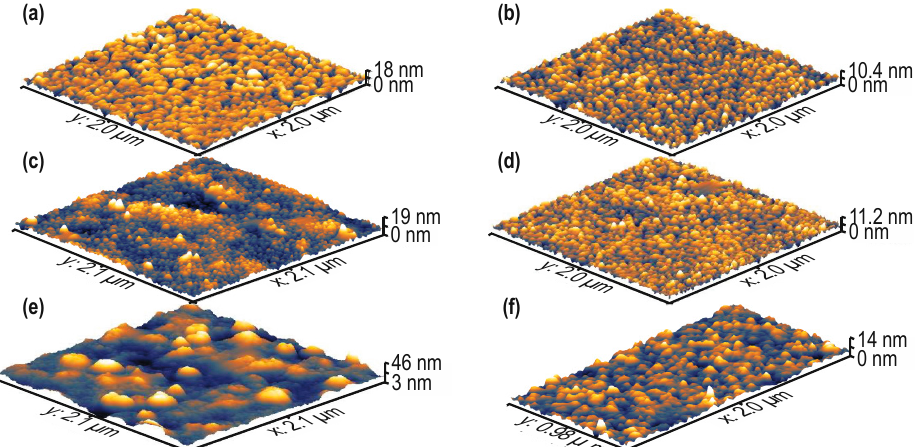
Figure A6. Atomic force microscope (AFM) topography image revealing the morphology of the thin film of (Bi 1-x Pr x )(Fe 0.95 Mn 0.05 )O 3 deposited on LAO substrate for the different Pr substitution concentrations: ( a ) 5%, ( b ) 10%, ( c ) 12.5%, ( d ) 15%, ( e ) 17.5%, and ( f ) 20%.